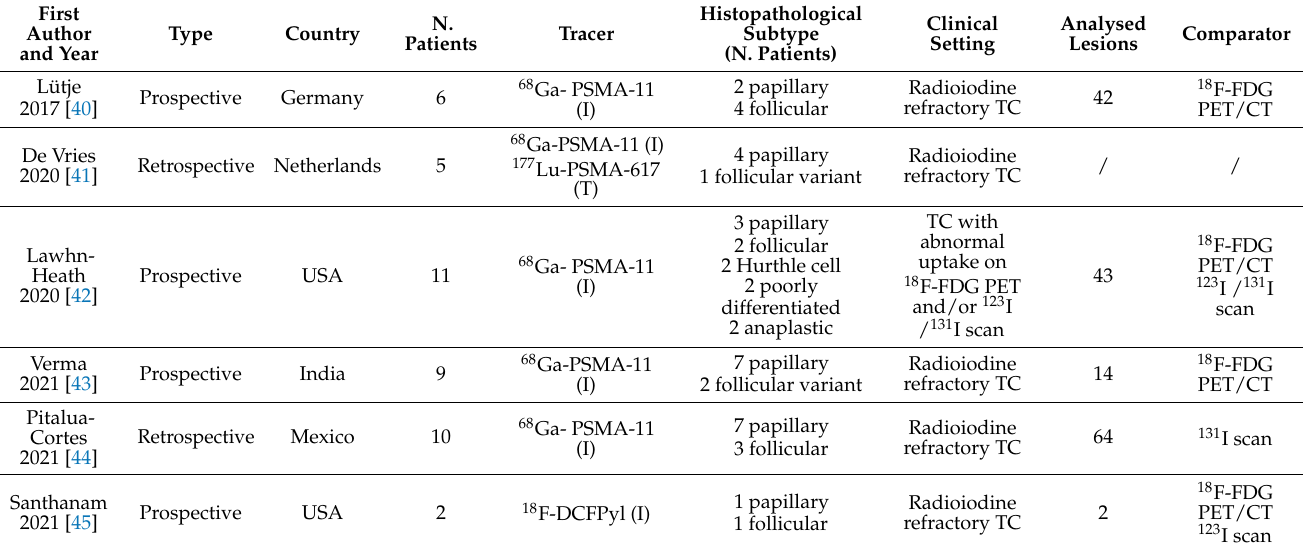
Table 3. Characteristics of the included studies which employed PSMA radioligands in thyroid